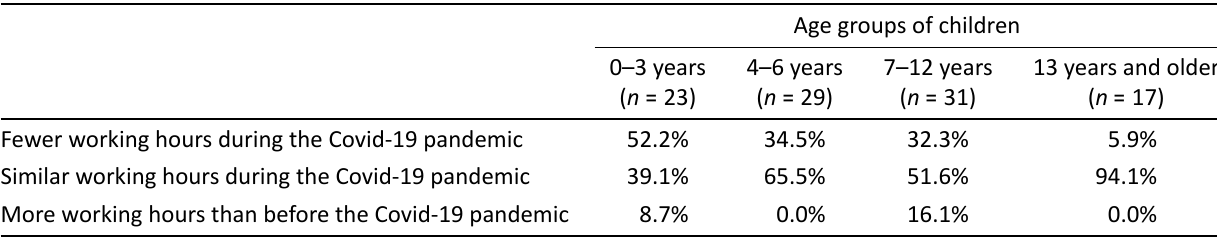
Table 5. Changes in working hours during the pandemic in relation to the age of children living in the household.